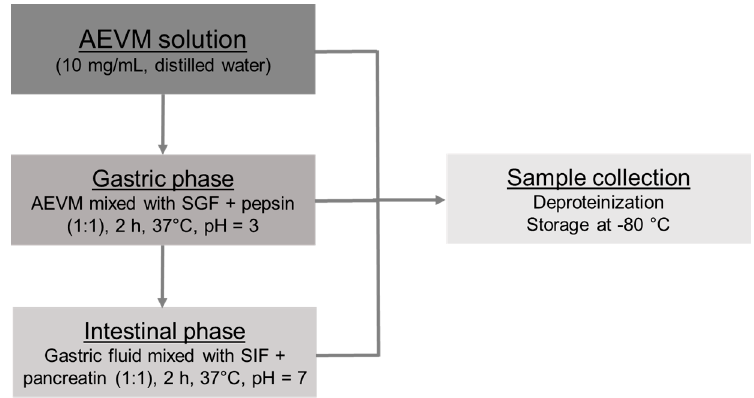
Figure 1. Flow diagram of the simulated in vitro digestion procedure. AEVM: Anthocyanin enriched extract from Vaccinium myrtillus , SGF: Simulated Gastric Fluid, SIF: Simulated Intestinal Fluid.